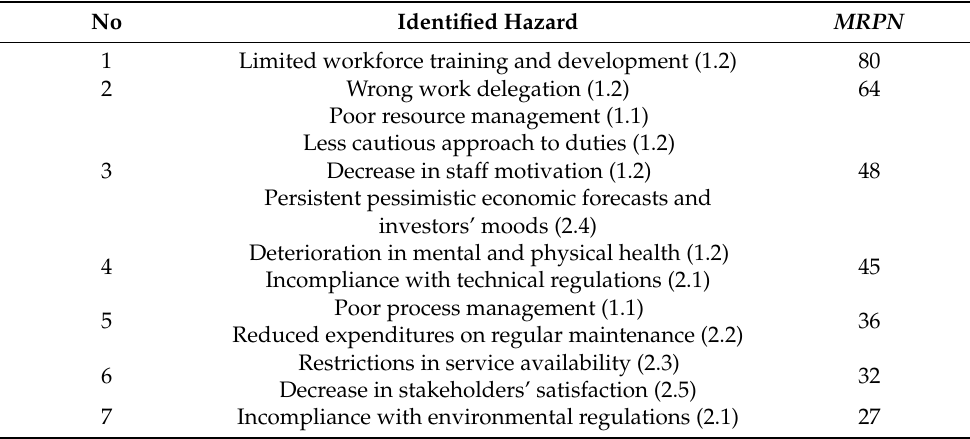
Table 6. Risk assessment results according to their criticality, own